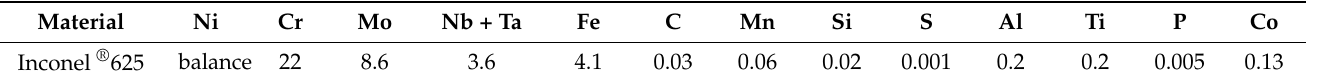
Table 1. Chemical composition of counter-specimen material